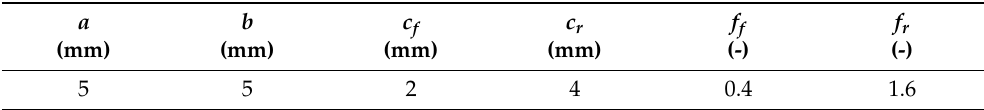
Table 9. Values of the double ellipsoidal heat source